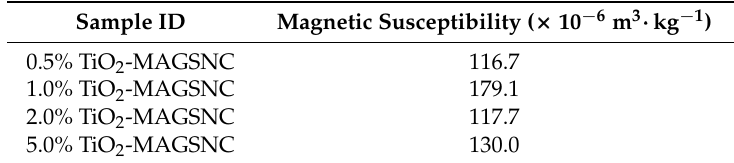
Table 3. The magnetic susceptibility of the TiO 2 -MAGSNC